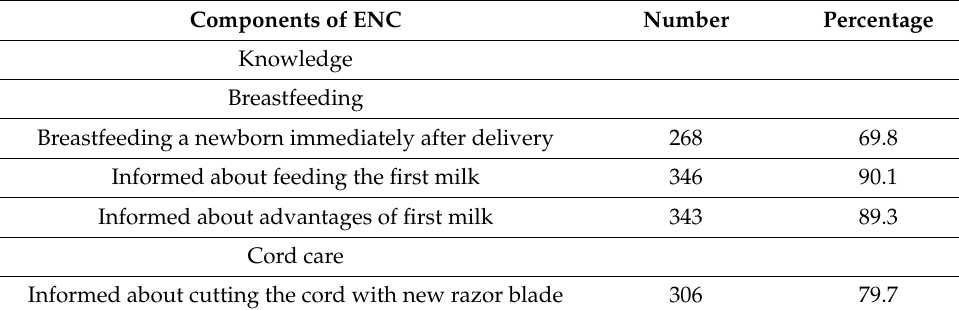
Table 2. The quality of ENC components of knowledge and